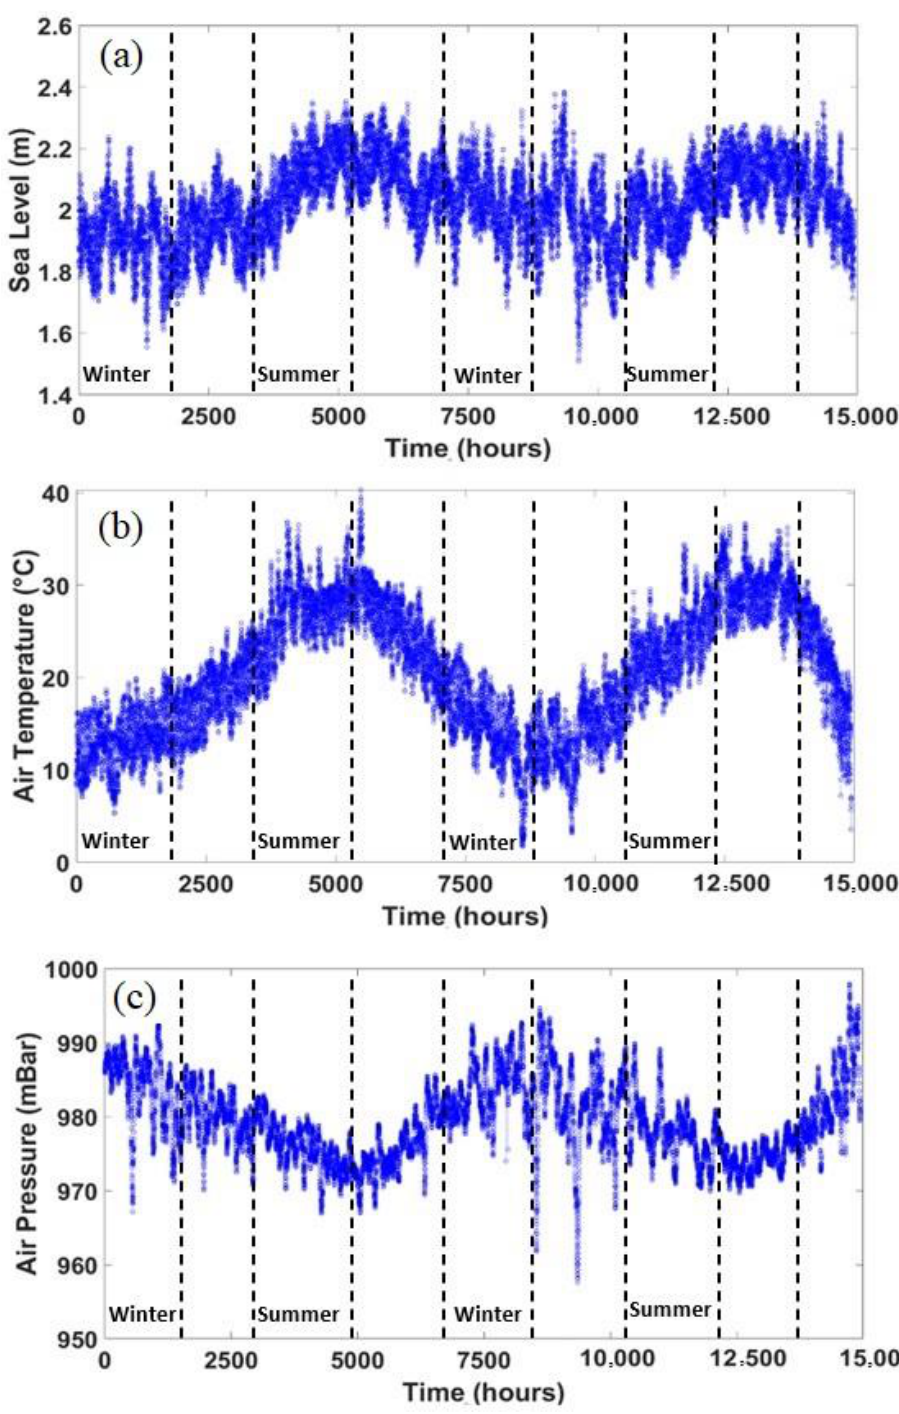
Figure 2. Time series of ( a ) sea level; ( b ) air temperature; ( c ) air pressure observed at Antalya tide gauge station.